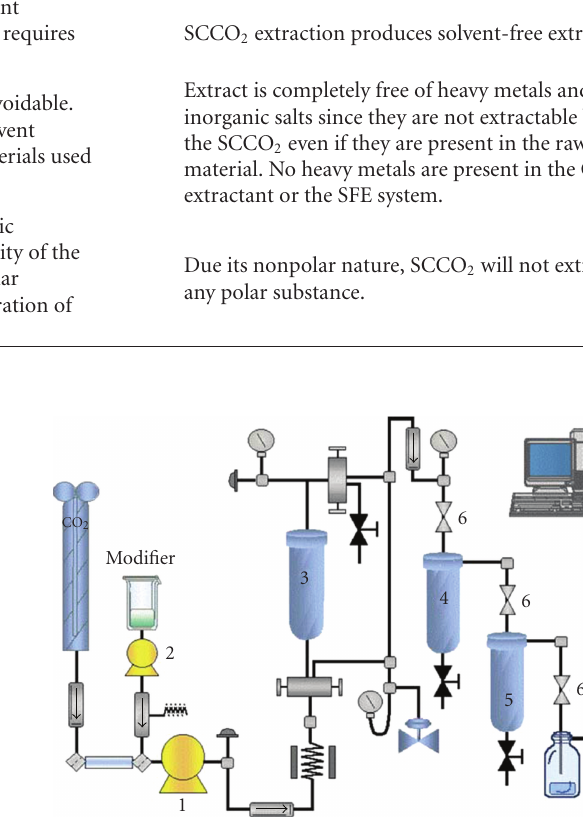
Figure 5: Schematic diagram of supercritical fluid extraction system, extracted from [45]. (1) CO 2 pump, (2) modifier pump, (3) extraction cell, (4) fractionation cell I, (5) fractionation cell II, (6)